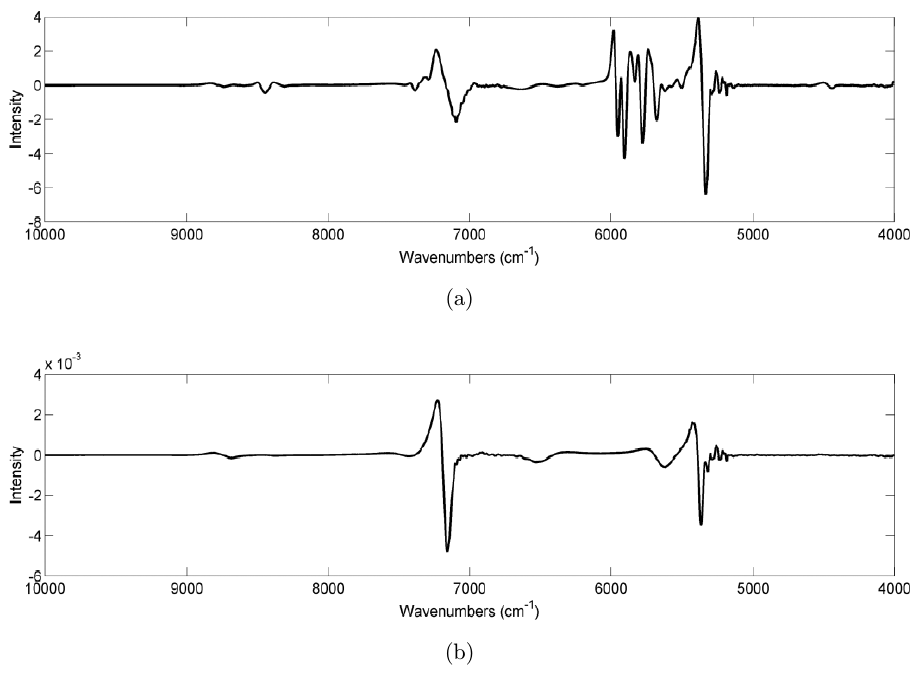
Fig. 4. The average spectrum of samples (a) The spectrum of normal saline and (b) (Second derivative pre-processing).